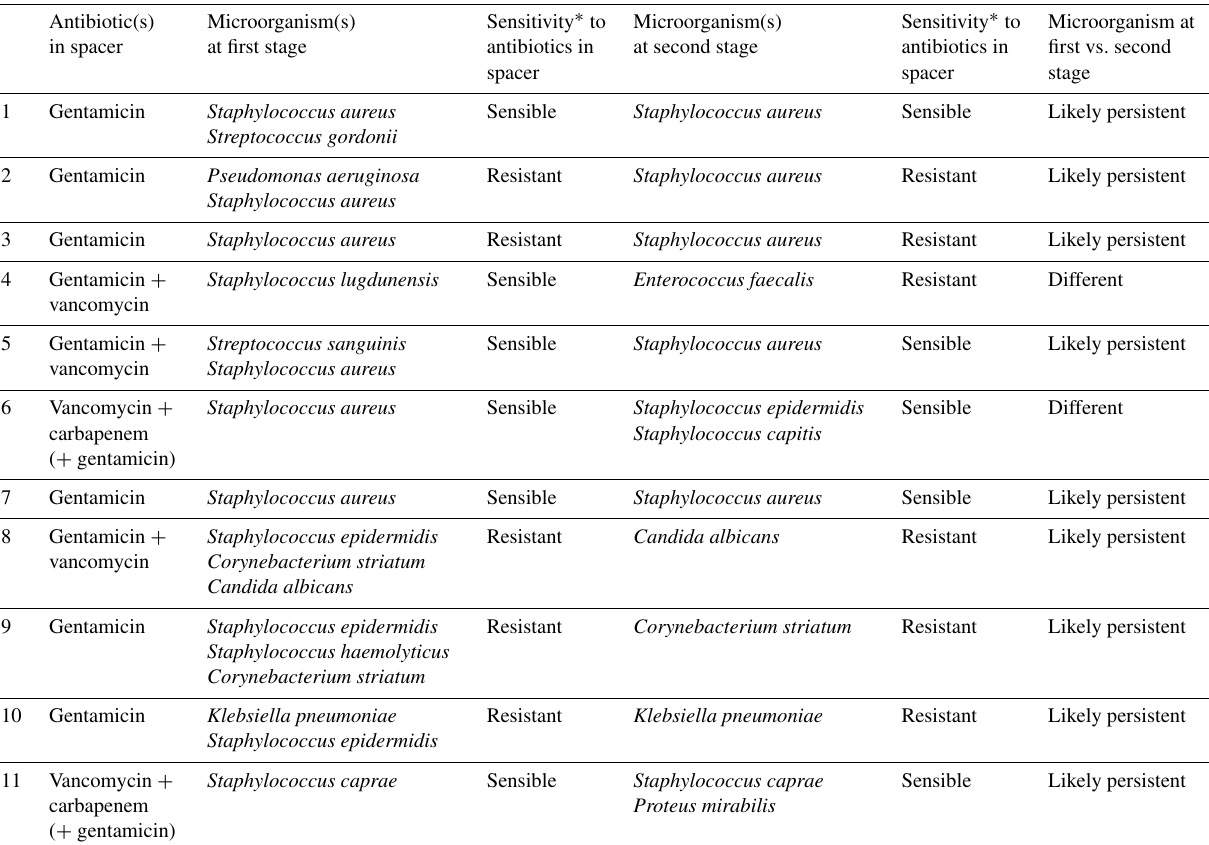
Table 5. Microbiological findings at the first stage and type of spacer used in those cases with positive culture cases at the second stage.